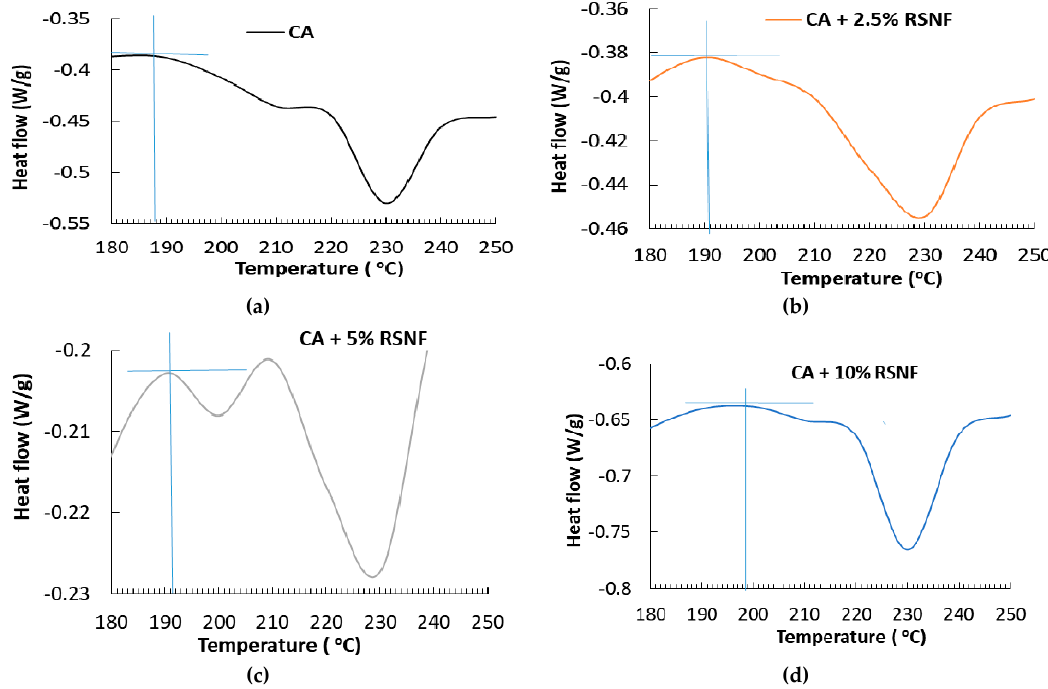
Figure A1. Enlarged areas of the DSC curves of CA and CA/RSNF nanocomposites used for estimation the T g of samples. ( a ) CA; ( b ) CA + 2.5% RSNF; ( c ) CA + 5% RSNF; ( d ) CA + 10% RSNF.